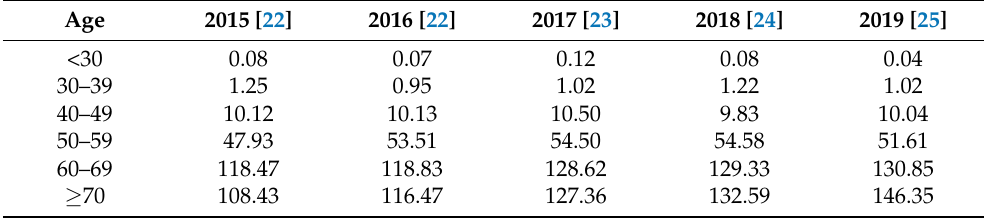
Table 3. Incidence of diabetes-related lower extremity amputations/100,000 persons/year, according to age in the general population.